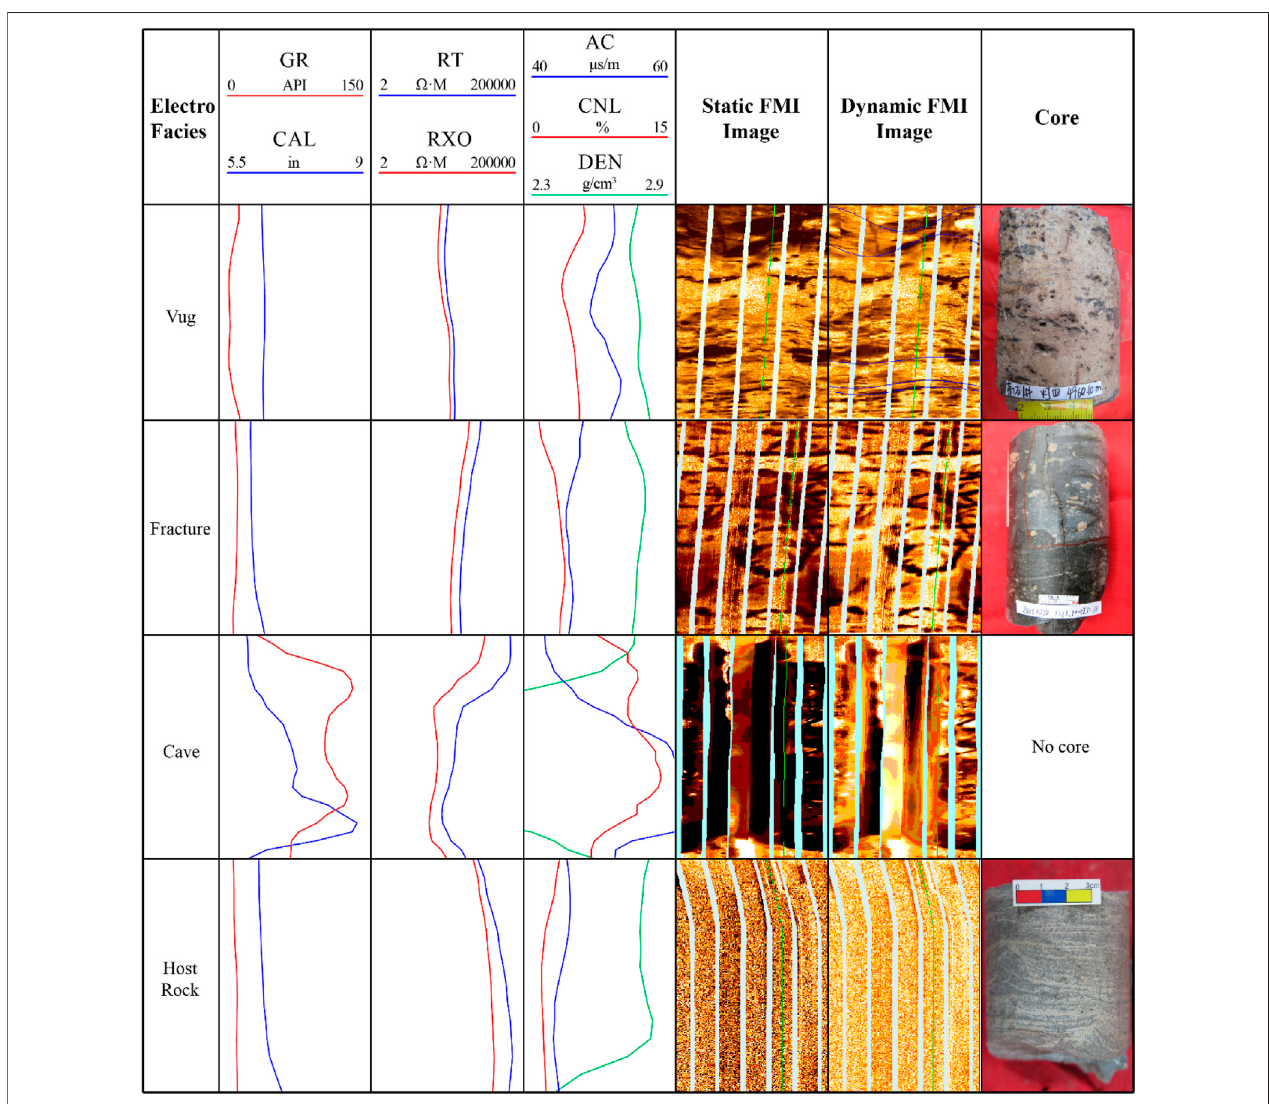
FIGURE 4 | Conventional logging response and FMI characteristics of the four types of electrofacies.